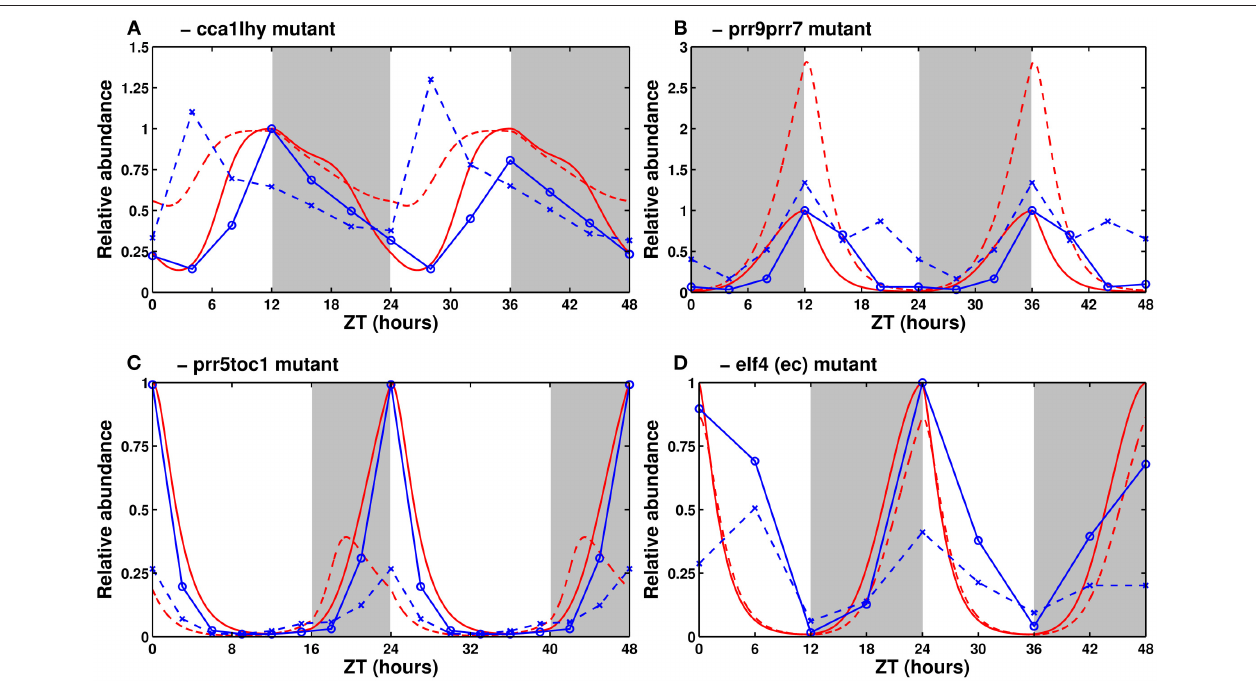
FIGURE 5 | Expression of clock genes in loss-of-function mutants. Experimental (in blue) and simulated mRNA levels (in red) in various clock mutants (dashed lines) and their respective wild types (solid lines). (A) Experimental TOC1 and simulated PRR5/TOC1 expression in the cca1lhy mutant. Data from Mizoguchi et al. (2002). (B) CCA1/LHY expression in the prr9prr7 mutant. Data from Farré et al. (2005). (C) Experimental LHY and simulated CCA1/LHY expression in the prr5toc1 double mutant. Data from Ito et al. (2008). (D) Experimental CCA1 and simulated CCA1/LHY expression in the elf4 mutant. Data from McWatters et al. (2007). All values are normalized to the maximum of the respective wild type. The sources for (B,C) have, respectively, 24 and 21 h worth of data, duplicated here for the sake of homogeneity between